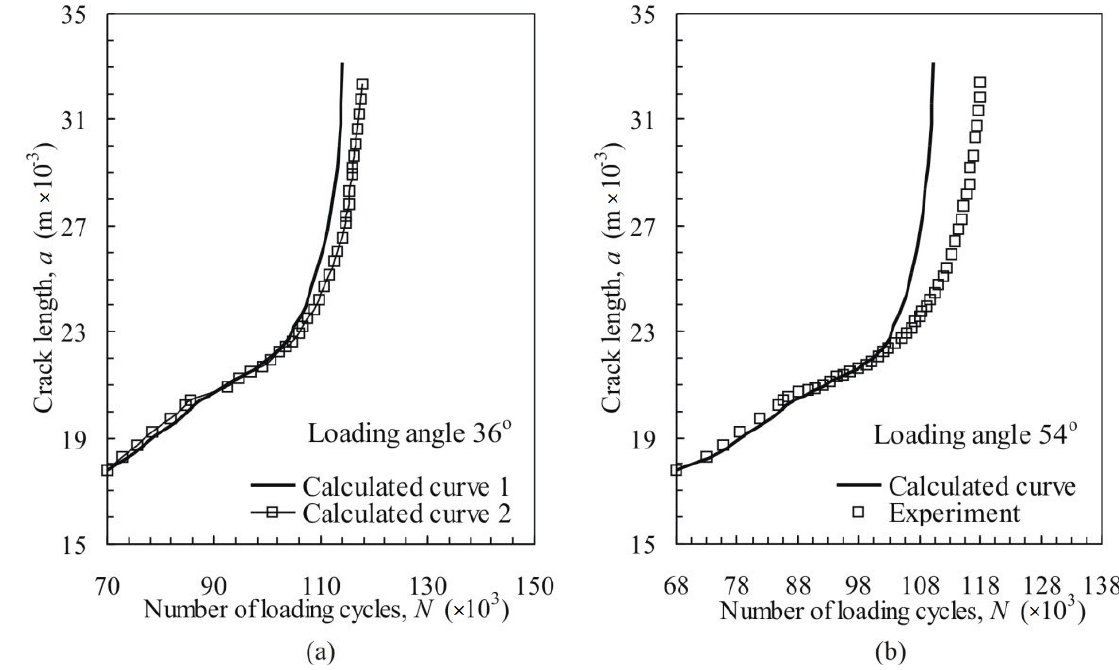
Figure 7. Fatigue resistance analysis: ( a ) a versus N ( φ = 36°), 1—calculated curve from the present work, 2—calculated curve from Reference [19] and ( b ) a versus N ( φ = 54°), calculated curve from the present work, experiments reported by Mohanty et al. [19].